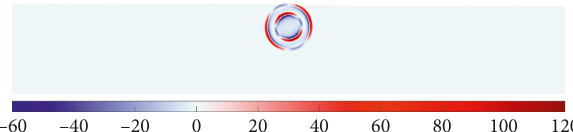
Figure 13: Velocity distribution in the x direction at time � 5 s.